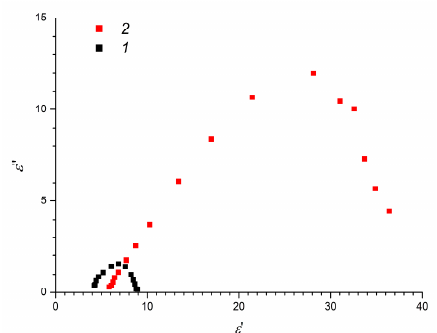
Figure 6. Cole–Cole diagrams for TiO 2 -modified elastomers: (1) ERE-0; (2) ERE-5.